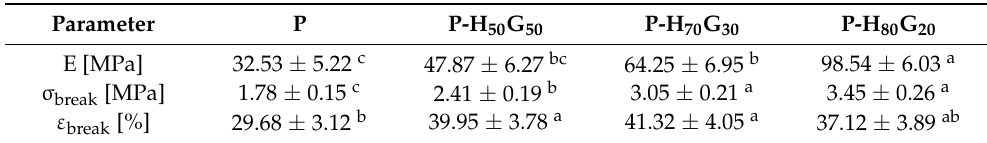
Table 4. Mechanical parameters of pectin and pectin